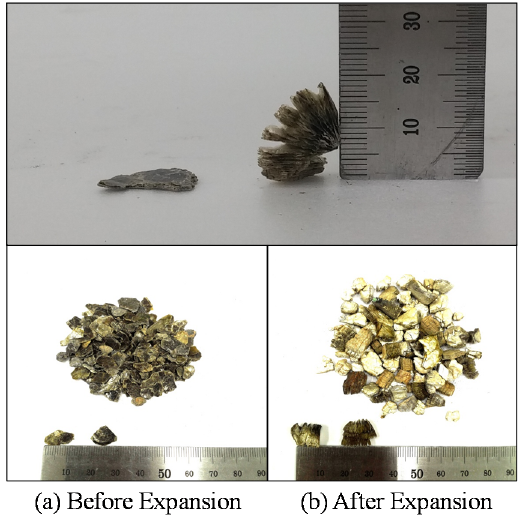
Figure 1. Thermal expansion of the vermiculite materials.